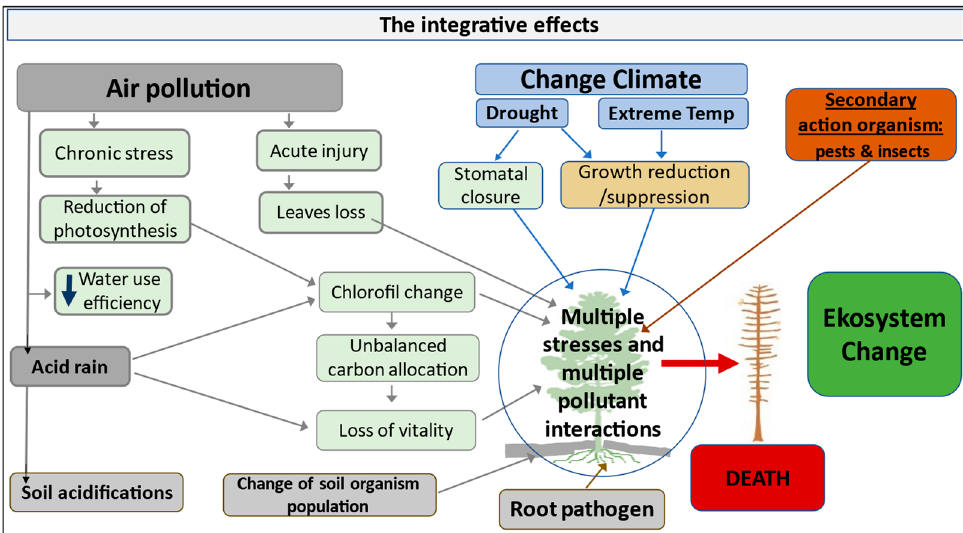
Figure 1. A schematic, integrated influence of air pollution, climatic conditions, and pathogens on trees. Explanation of the colours used in the figure: green—changes taking place in plants; grey—changes in the soil environment; brown—a growth reaction recorded in tree rings.